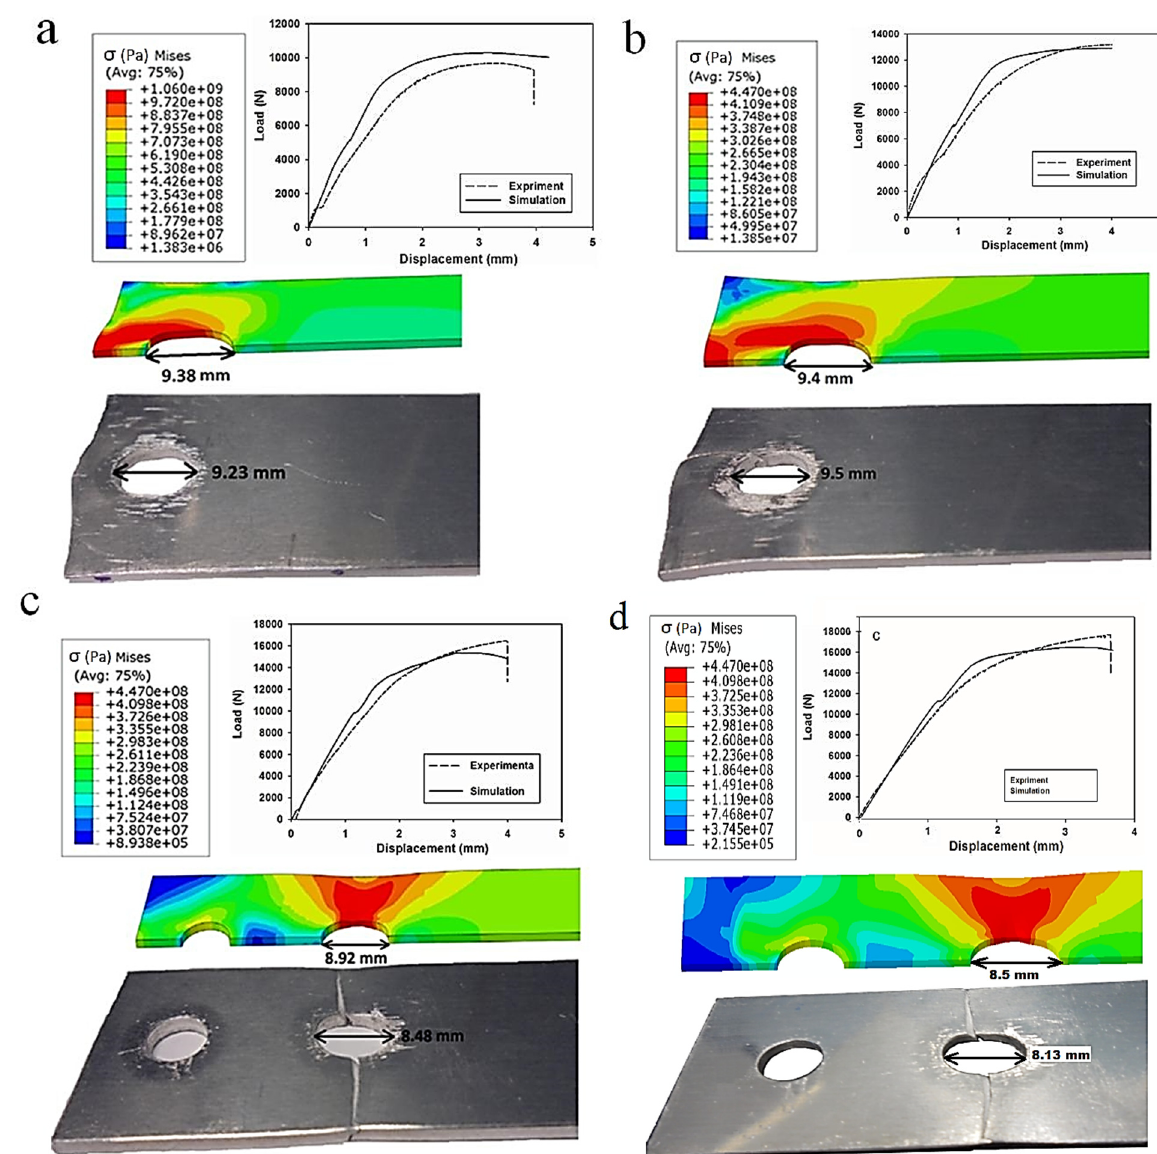
Figure 3. A comparison between experimental and numerical results of load-displacement curves along with the hole deformation: ( a ) SW1e1; ( b ) SW1e2; ( c ) DW1e1; and ( d ) DW1e2. The stress contours are von Mises stresses in